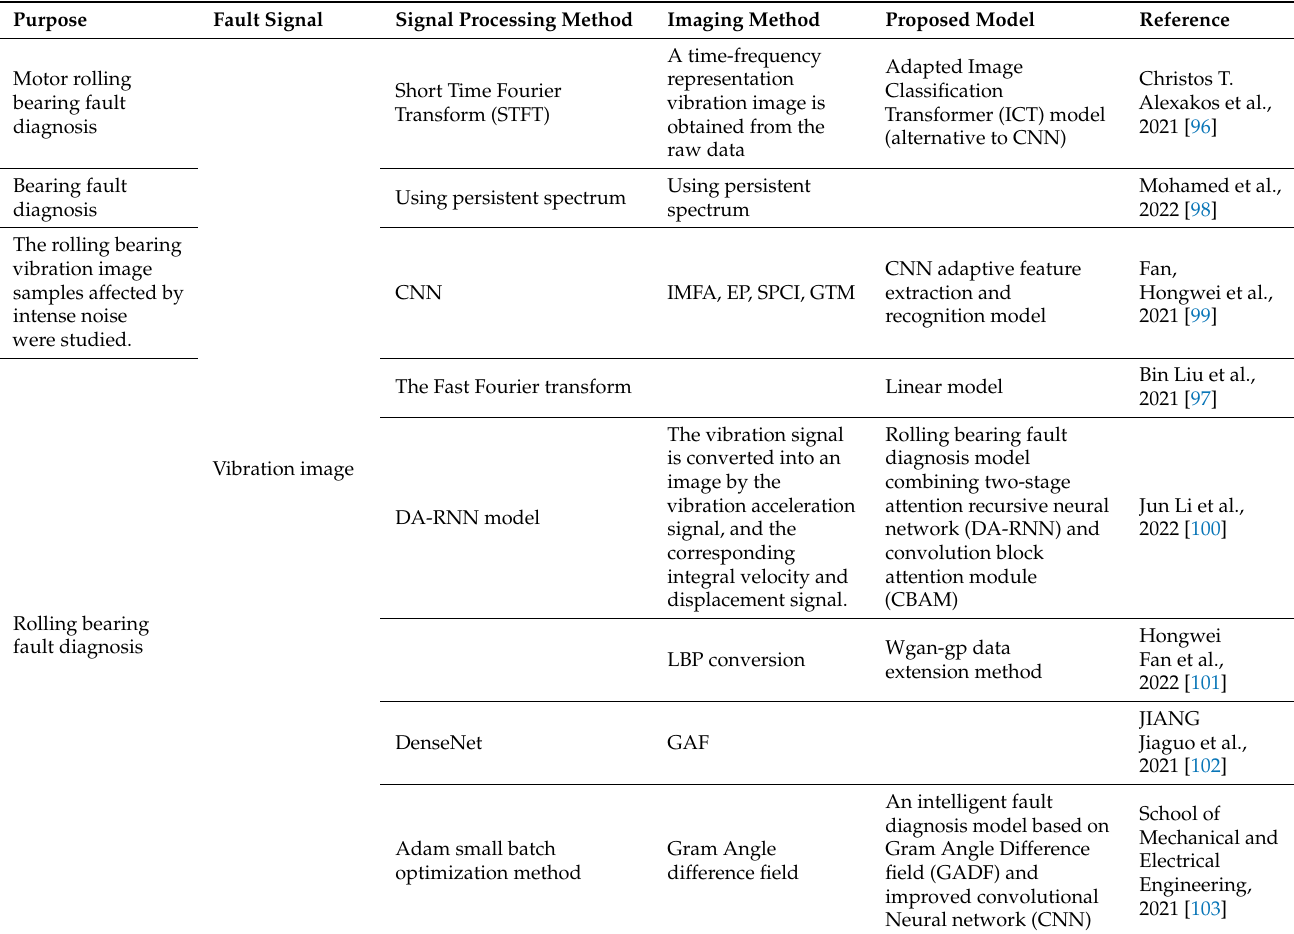
Figure 7. CNN structural diagram [99]. Figure 7 [99] . CNN structural diagram. Table 9. Summary table of two-dimensional-image Table 9. Summary table of two-dimensional-image methods.